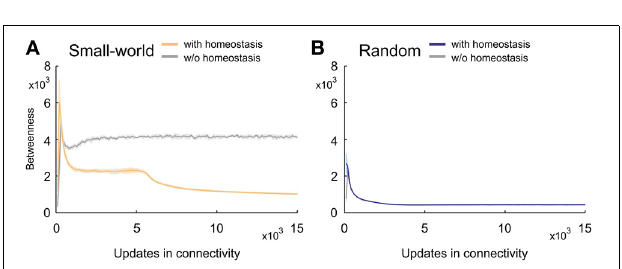
over time. The black curve (right y-axis) indicates the course of the calcium (cid:6) (cid:5) . In (B,D) , we plotted synapse formation and deletion in concentration Ca 2 + (cid:6) (cid:5) . The color code inallpanels indicates thedensity of the dependence on Ca 2 + dots in the diagrams, with blue and red representing low and high densities of dots,respectively.Thefigureessentiallyshowsthatbeforecalciumreachesthe homeostatic set-point (cid:4) , the distribution for synapse formation is rather Gaussian, following the Kernel function K (Equation 5). The distribution becomes random and scattered, with increased Euclidean distances, when calciumisattheset-point.Thestripesinthedistributionarisefromthefactthat not all Euclidean distances are possible due to the grid layout of the network. There is no change in the distribution for synapse deletion.